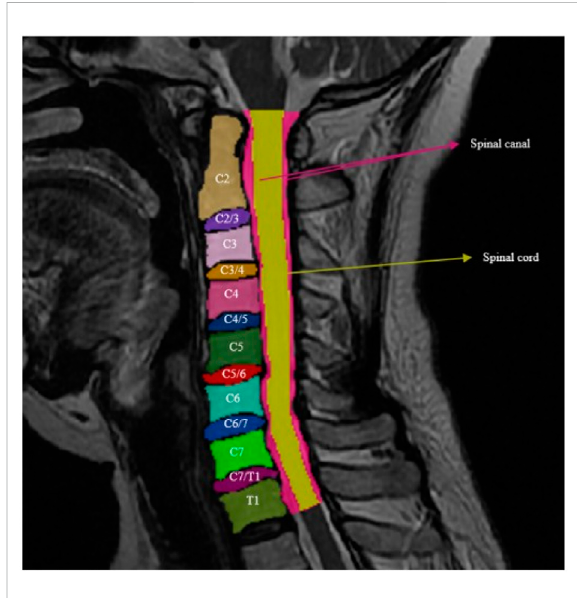
FIGURE 5 Cervical bodies: C2, C3, C4, C5, C6, C7, and T1; cervical intervertebraldisc:C2/3,C3/4,C4/5,C5/6,C6/7,andC7/T1;spinal canal; and spine